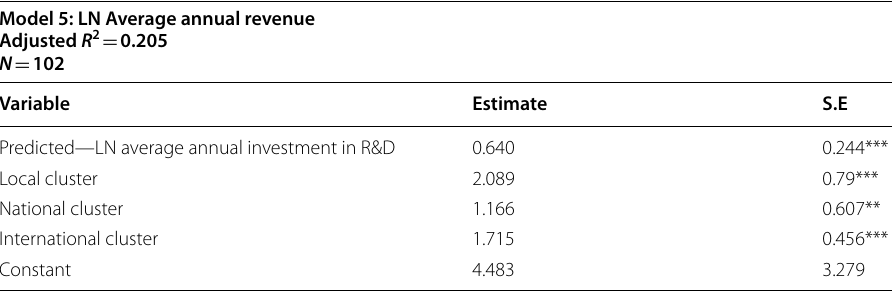
Table 6 Multiple regression model estimation of the contribution of cluster var. to LN average annual product